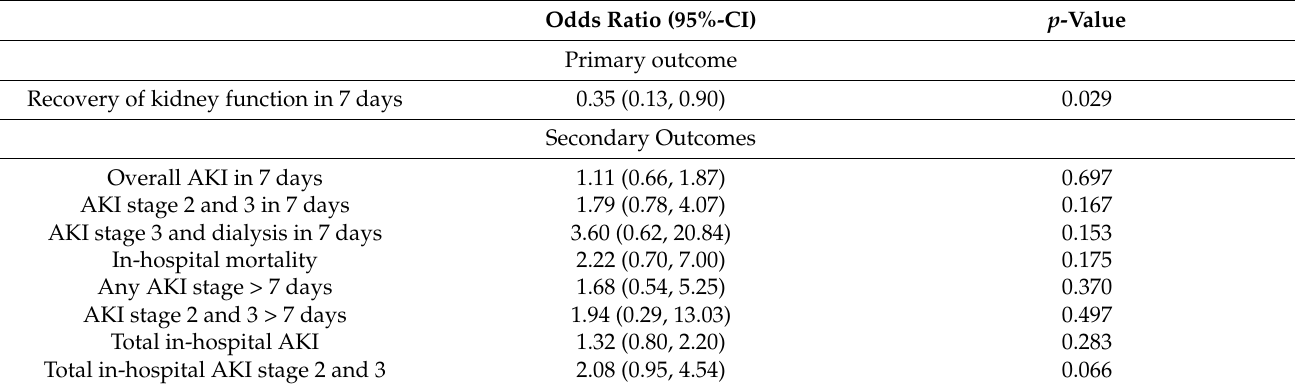
Table 4. Clinical outcome of protocol implementation group vs. historical control group (multivariable-adjusted